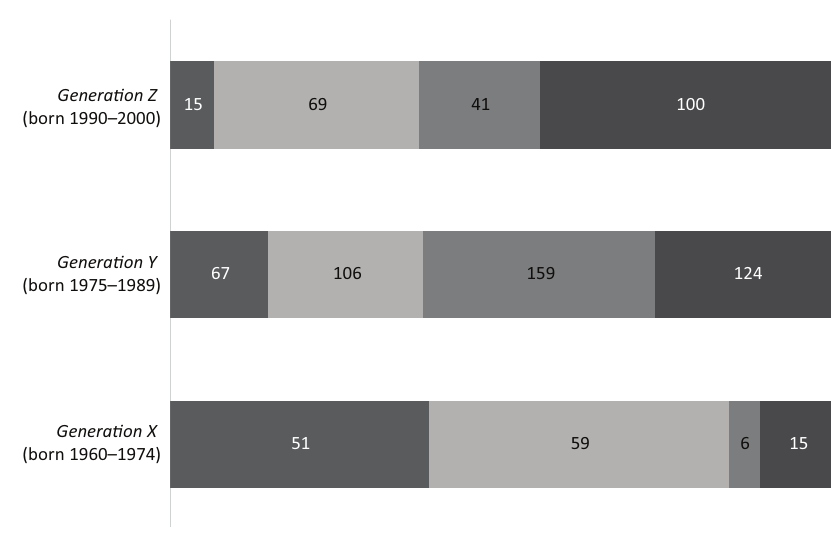
fig. 6. Demand for physical meeting with social network associates, N = 812